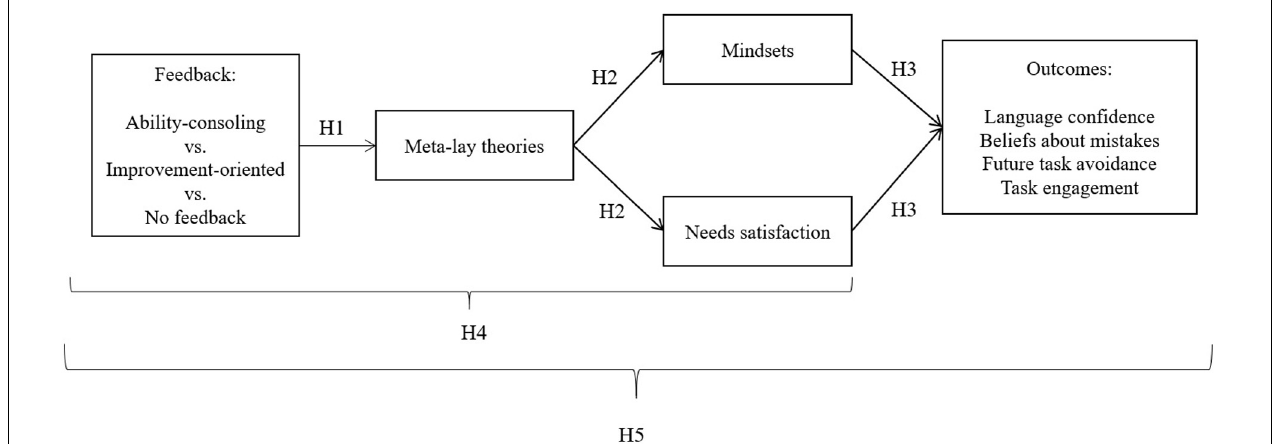
FIGURE 1 | Hypothesized path